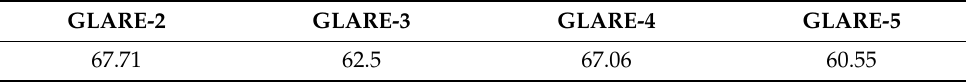
Table 4. The longitudinal flexural modulus, E f x ( GPa ) , of GLARE FMLs with different stacking sequence of composite materials.